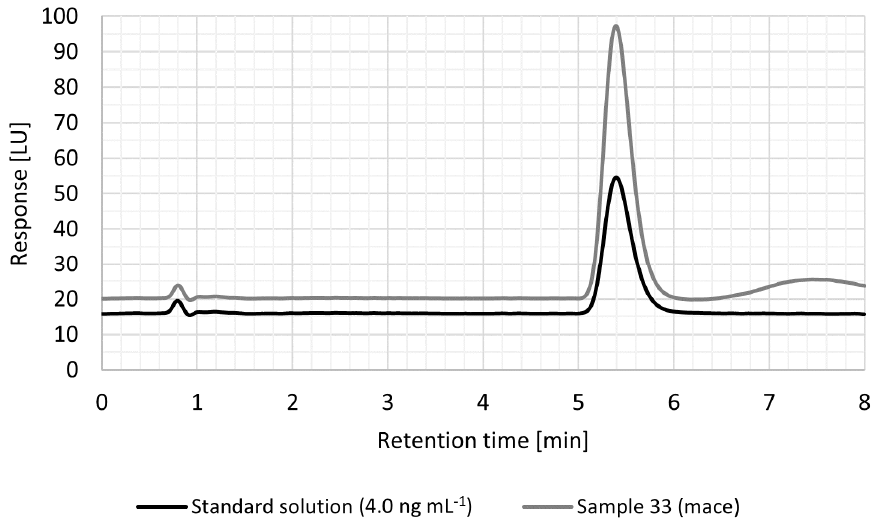
Figure 2. HPLC-FLD chromatogram showing peaks of OTA in spice sample 33 (mace) and standard solution (4.0 ng mL − 1 ) at a retention time of 5.4 min.